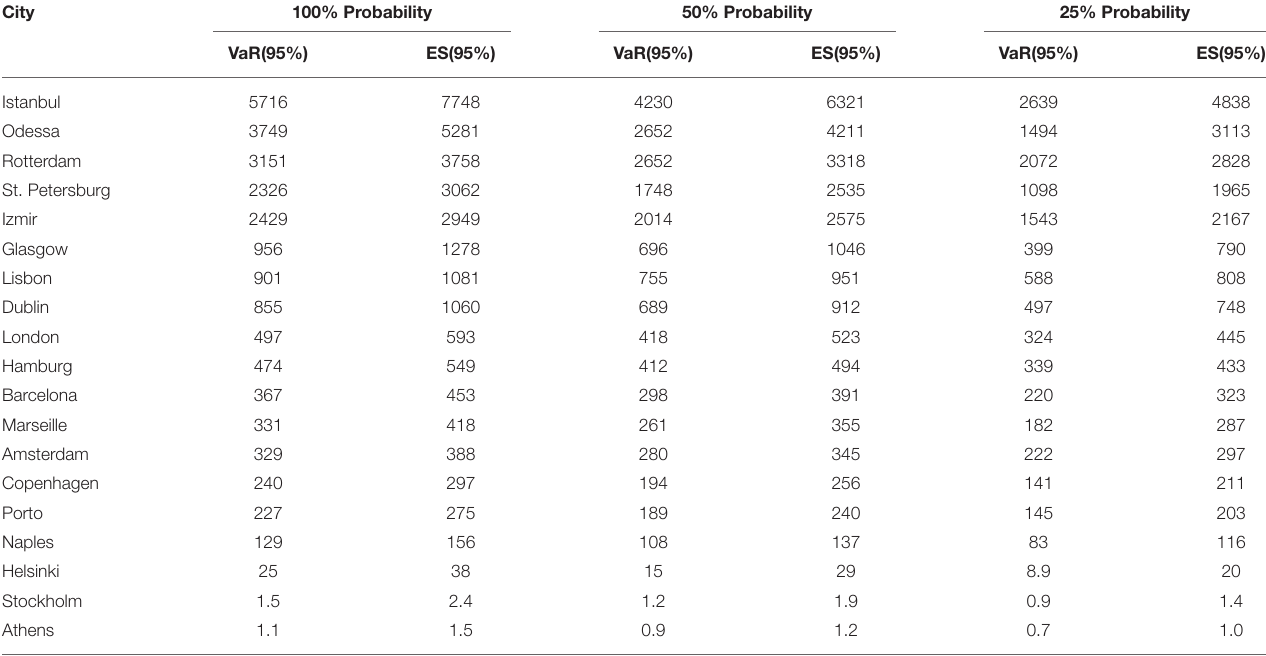
TABLE 6 | Losses in European cities for different probabilities of occurrence of RCP8.5 in 2050. City